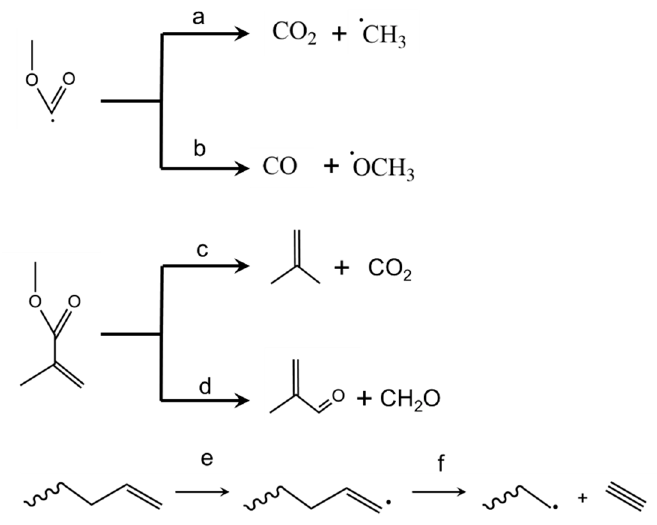
Figure 16. Examples of side reactions blocking MMA formation ( a , b ) leading to the formation of neutral CO 2 and CO as well as OCH 3 and CH 3 radicals; note that upon subsequent hydrogen abstraction methanol and methane are formed. ( c , d ) direct decomposition products of methyl methacrylate (MMA); ( e , f ) formation of acetylene assuming already the removal of CH 3 groups.